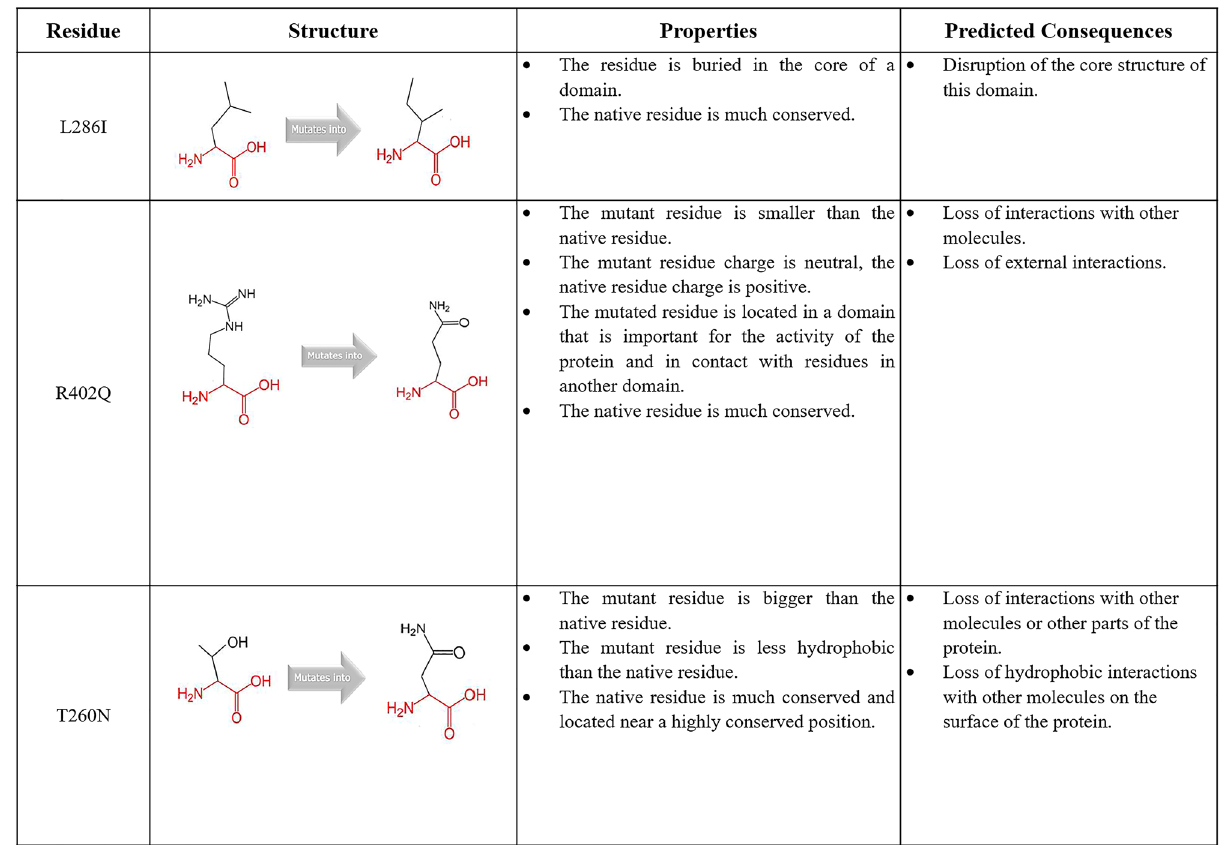
Figure 3. Schematic structures of the original (left) and mutant (right) amino acid for each mutation. The backbone, which is the same for each amino acid, is colored red. The side chain, unique for each amino acid, is colored black. Data obtained from HOPE